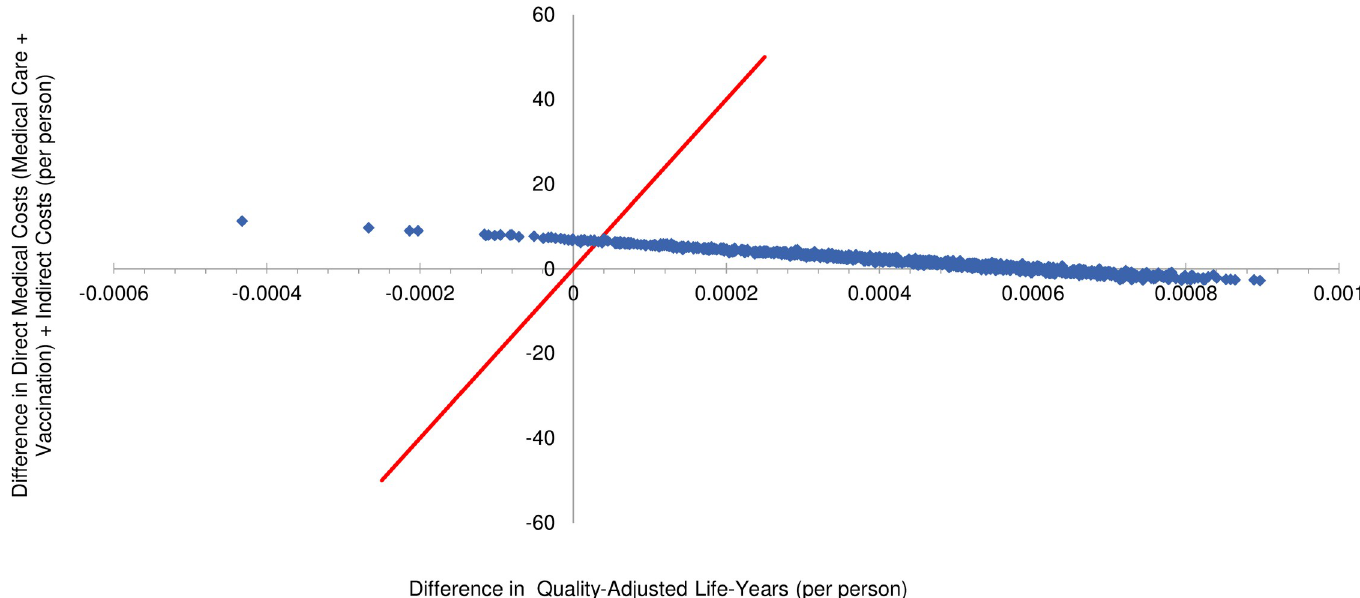
Fig 7. Graphical illustration of PSA for the private health care sector mixed model. Costs are indicated in 2015 South African rand.